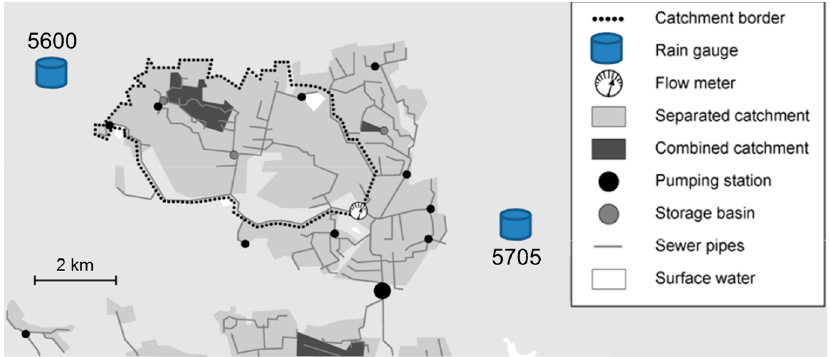
Figure 5. Ballerup catchment (Edited from [37]).